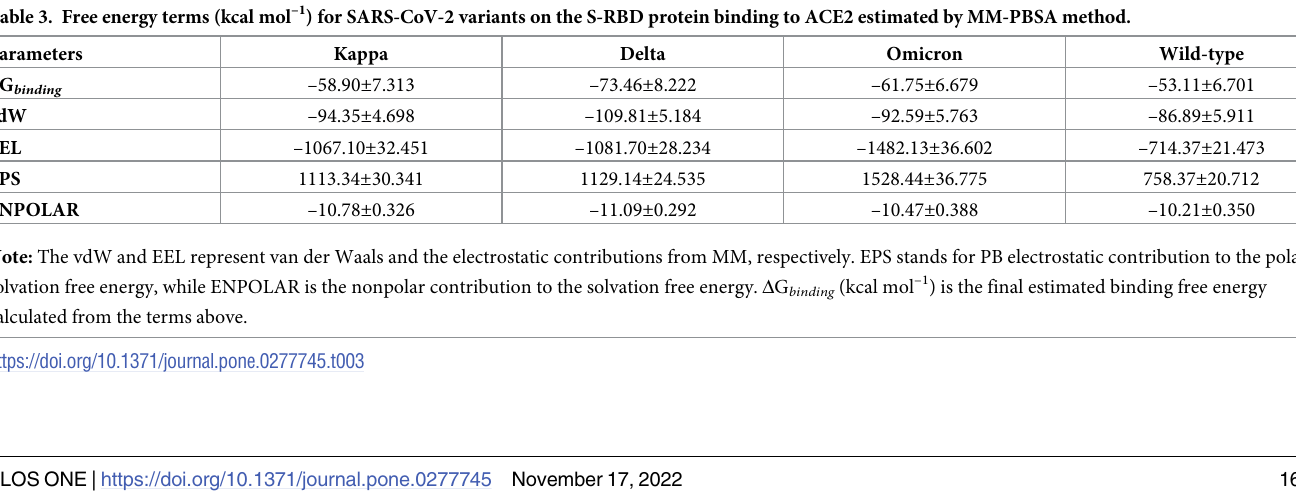
Table 3. Free energy terms (kcal mol –1 ) for SARS-CoV-2 variants on the S-RBD protein binding to ACE2 estimated by MM-PBSA method. Parameters Kappa